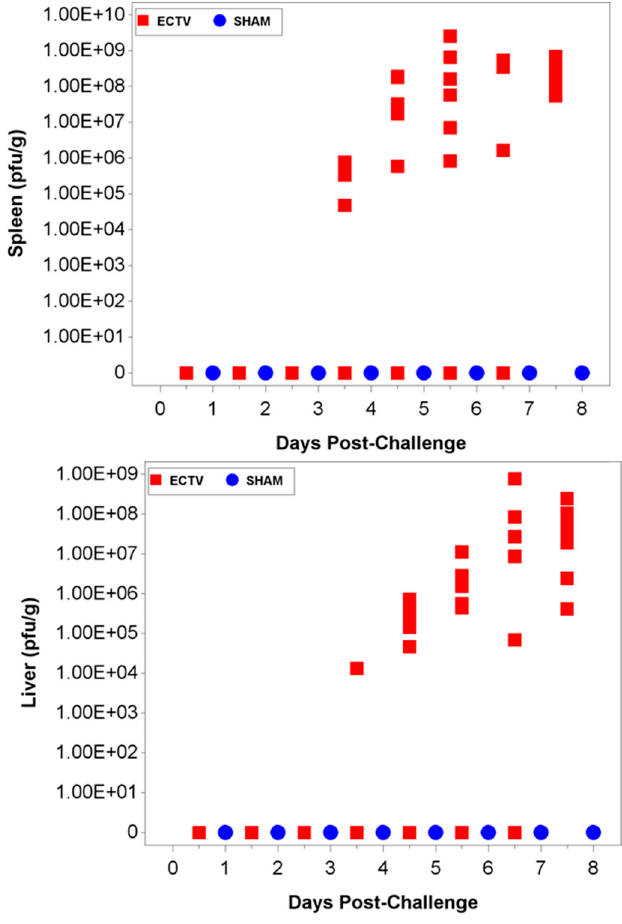
Figure 8. Viral load in tissues as measured by the plaque assay. ( A ) the first positive viral titer displayed in the spleen was observed at 3.5 days PI. Titers ranged from 10 4 to 10 9 PFU/g up to 7.5 days PI; ( B ) viral titers in the liver were first observed at 3.5 days PI. Titers ranged from 10 4 to 10 9 PFU/g up to 7.5 days PI. Approximately 76% of liver samples collected at 3.5 days PI or later were positive for virus via the plaque